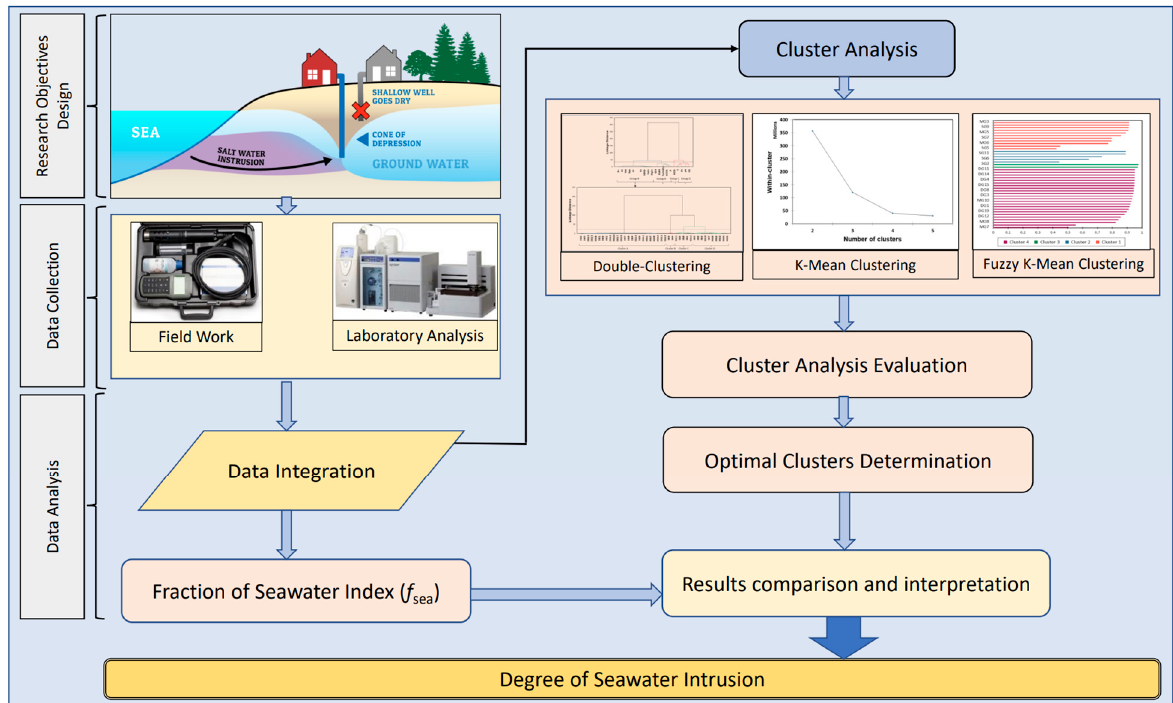
Figure 2. Flowchart showing the proposed methods and procedures.